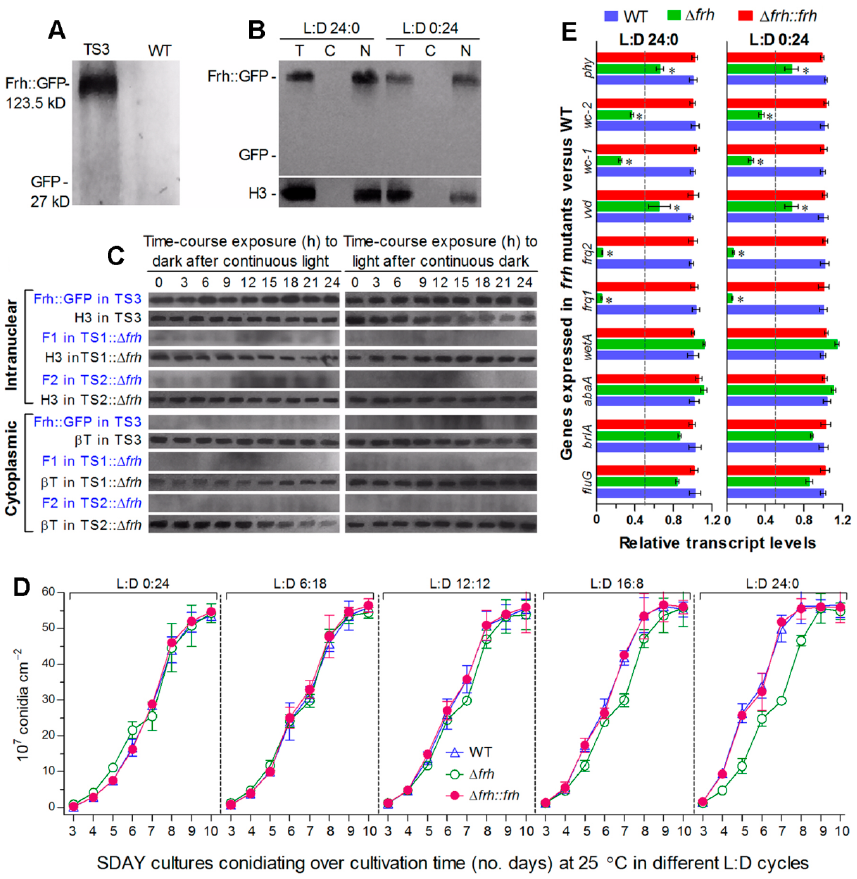
Figure 4. Nuclear FRH is required for Frq1 and Frq2 to function in nucleus. ( A , B ) Western blots for accumulation levelsof GFP and FRH::GFP in the total protein extracts of transgenic strain (TS3) and WT cultures at L:D 12:12 and of FRH::GFP in the total (T), cytoplasmic (C), and nuclear (N) protein extracts of 3-day-old TS3 cultures grown in SDBY at 25 ◦ C and L:D 24:0 or 0:24. ( C ) Time-course western blots for accumulation levels of FRH::GFP in TS3 and of Frq1::GFP (F1) and Frq2::GFP (F2) in TS1:: ∆ frh and TS2:: ∆ frh strains. Nuclear and cytoplasmic protein extracts were isolated from the hyphal cultures exposed 0–24 h (3-h interval) to dark after 60-h light incubation (left panels) or to light after 60-h dark incubation (right panels) of a 10 6 conidiamL − 1 suspension in SDBY at 25 ◦ C. Each lane was loaded with 60 µ g protein extract and probed by anti-GFP antibody. Nuclear standard: histone H3 probed by anti-H3 antibody. Cytoplasmic standard: β -tubulin ( β T) probed by anti- β -tubulin antibody. Note that accumulation level of FRH::GFP in TS3 was steadily high in nucleus during the time-course exposure but undetectable in cytoplasm and that deletion of frh led to residual or undetectable levels of F1 and F2 in both nucleus and cytoplasm. ( D ) Conidial yields measured from the SDAY cultures of frh mutants and WT during a 10-day incubation at 25 ◦ C in five L:D cycles. ( E ) Relative transcript levels of frq1 , frq2 , four photoreceptor genes and four developmental activator genes in the 3-day-old SDAY cultures of frh mutants versus WT grown at 25 ◦ C under light and dark conditions. The dashed line denotes a significance for one-fold repression. Error bar: SD of the mean from three replicates ( D ) or cDNA samples ( E ) analyzed through qPCR with primers (Table